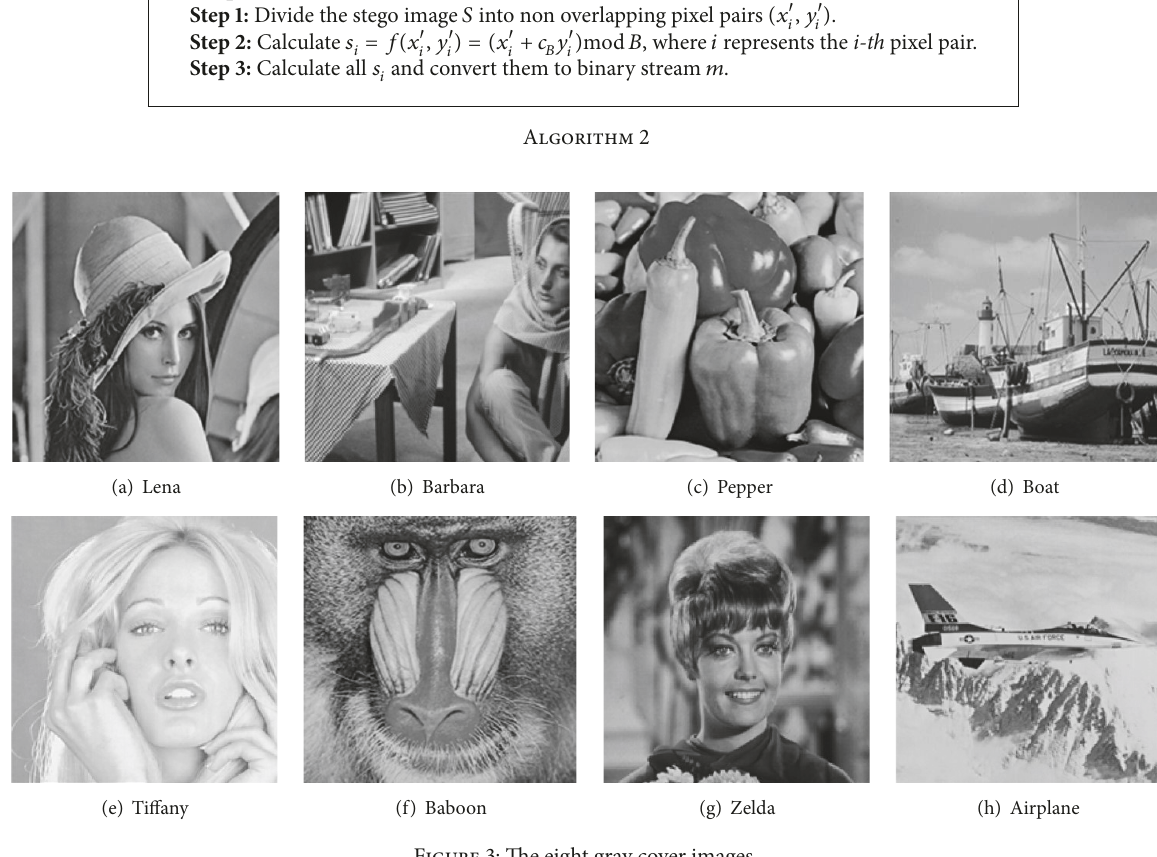
Figure 3: The eight gray cover images.